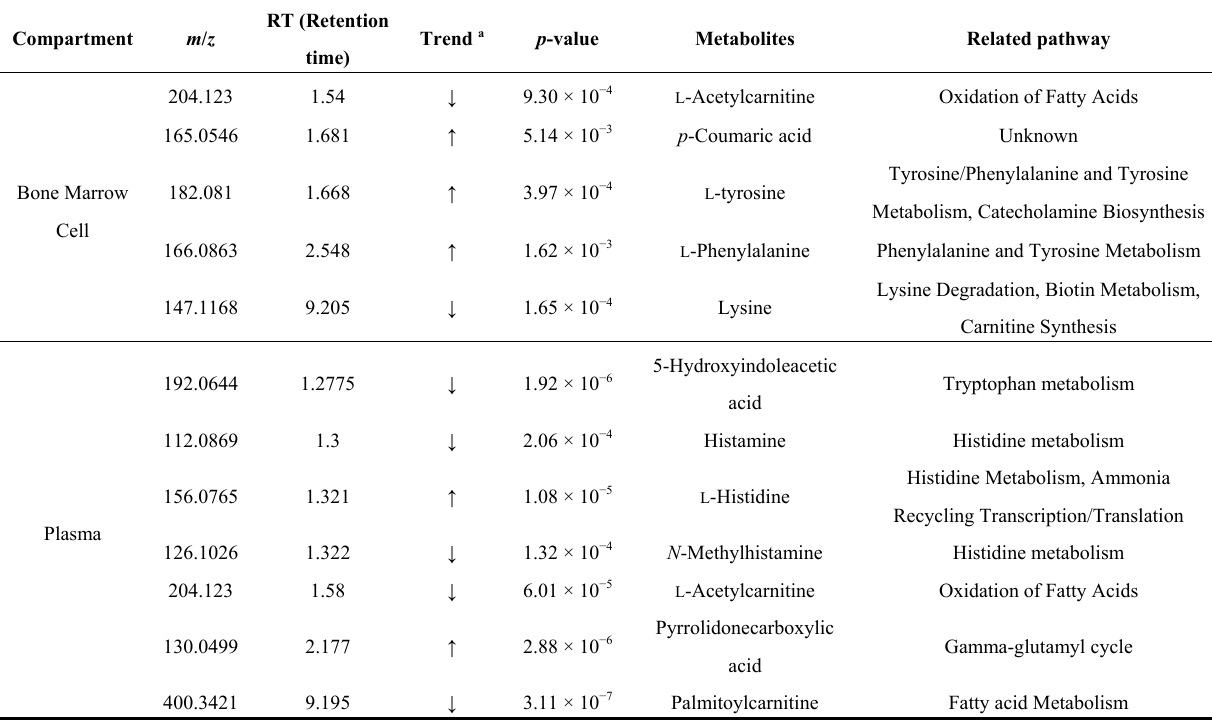
a Change trend of benzene exposure mice vs. control mice. Variations compared to control samples: ↑ , indicates relative increase in signal; ↓ , relative decrease in signal ( p <